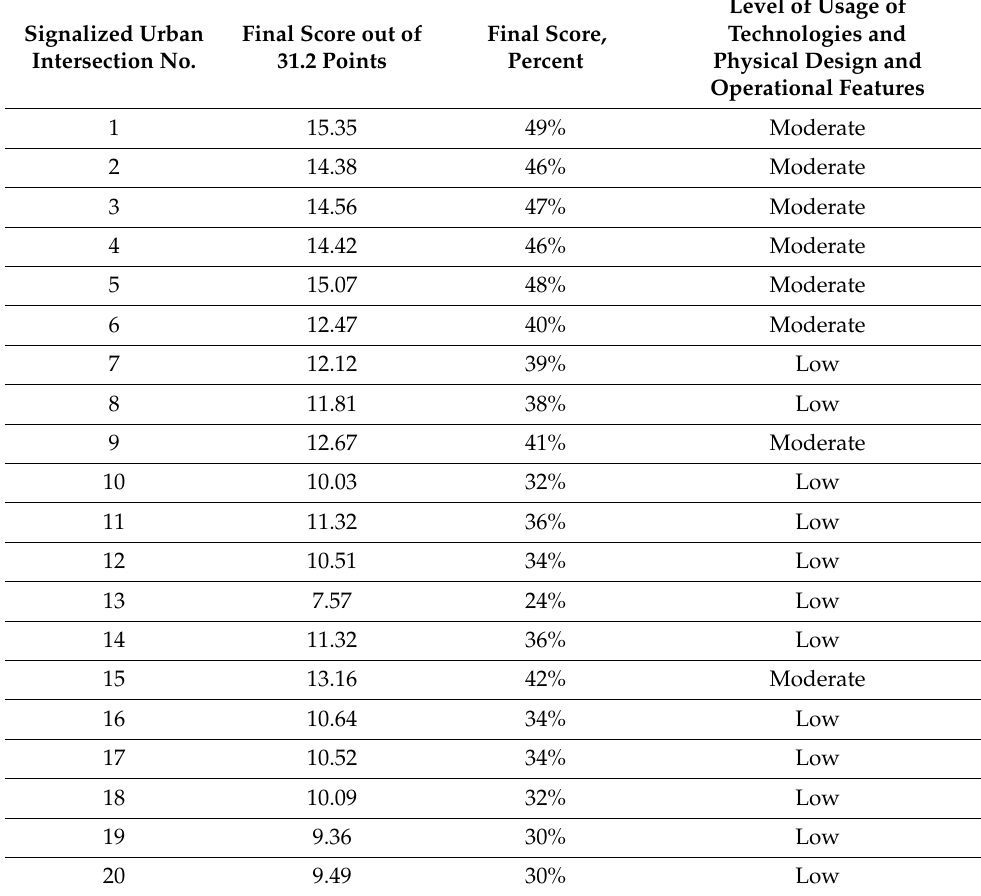
Table 3. Intersections’ final